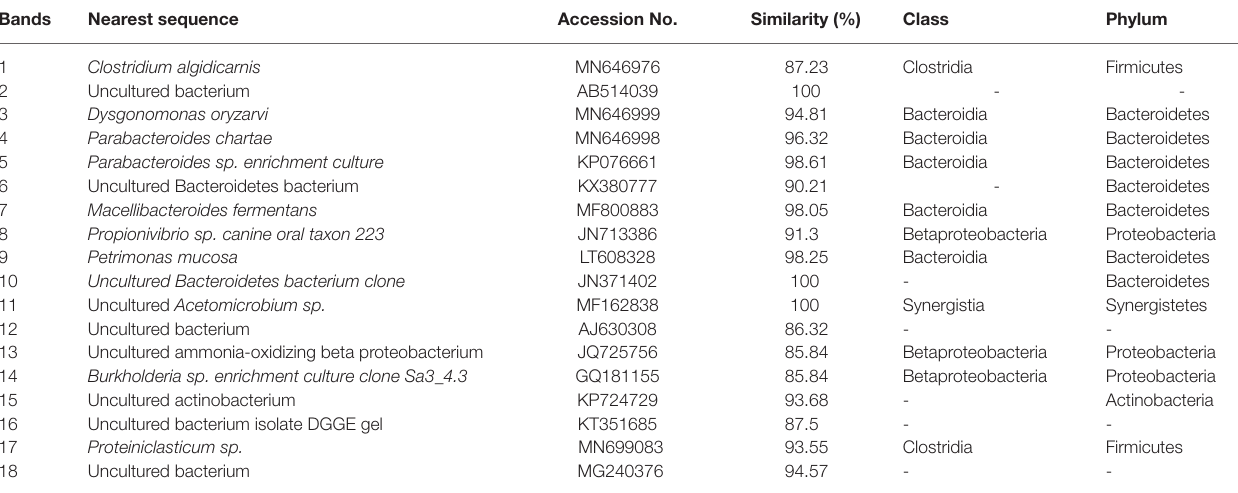
TABLE 1 | Phylogenetic affiliation of the bacteria from DGGE bands.